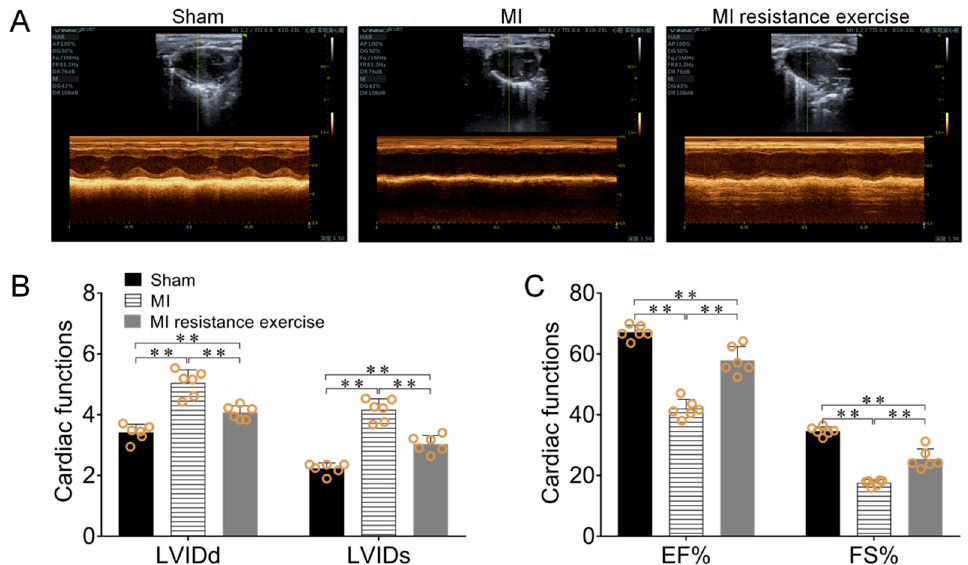
Figure 8. Resistance exercise reduced myocardial fibrosis, improved MI mice cardiac function. ( A , C ) Masson staining of heart sections for fibrosis evaluation and calculate fibrosis area by CVF. Collagen was stained blue and cardiomyocyte was stained red. ( A – C ) the effect of resistance exercise training on MI mice LVIDd, LVIDs, EF and FS. Data are expressed as mean ± SEM ( n = 6). ** p < 0.01. Abbreviations: LVIDs: Left ventricular internal diameter at end systole, LVIDd: Left ventricular internal diameter at end diastole, EF: Ejection fraction, FS: Left ventricular fractional shortening.